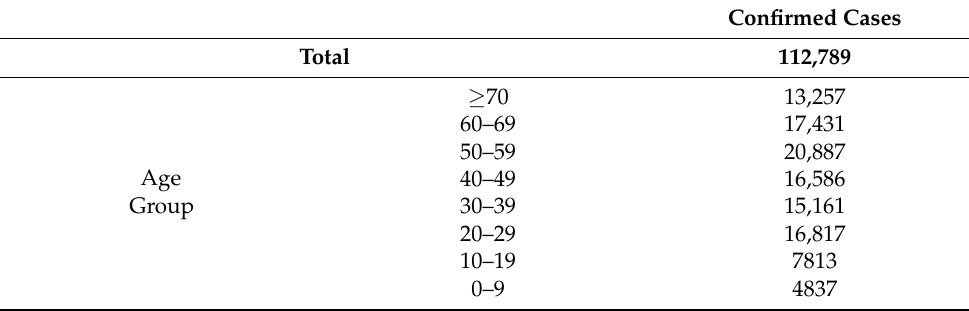
(Table 1) [2]. Population distribution in age groups and age-stratified contact rates in South Korea were used to parameterize our mathematical model. Table 1. Cumulative number of cases grouped by age in South Korea (as of 16 April 2021).